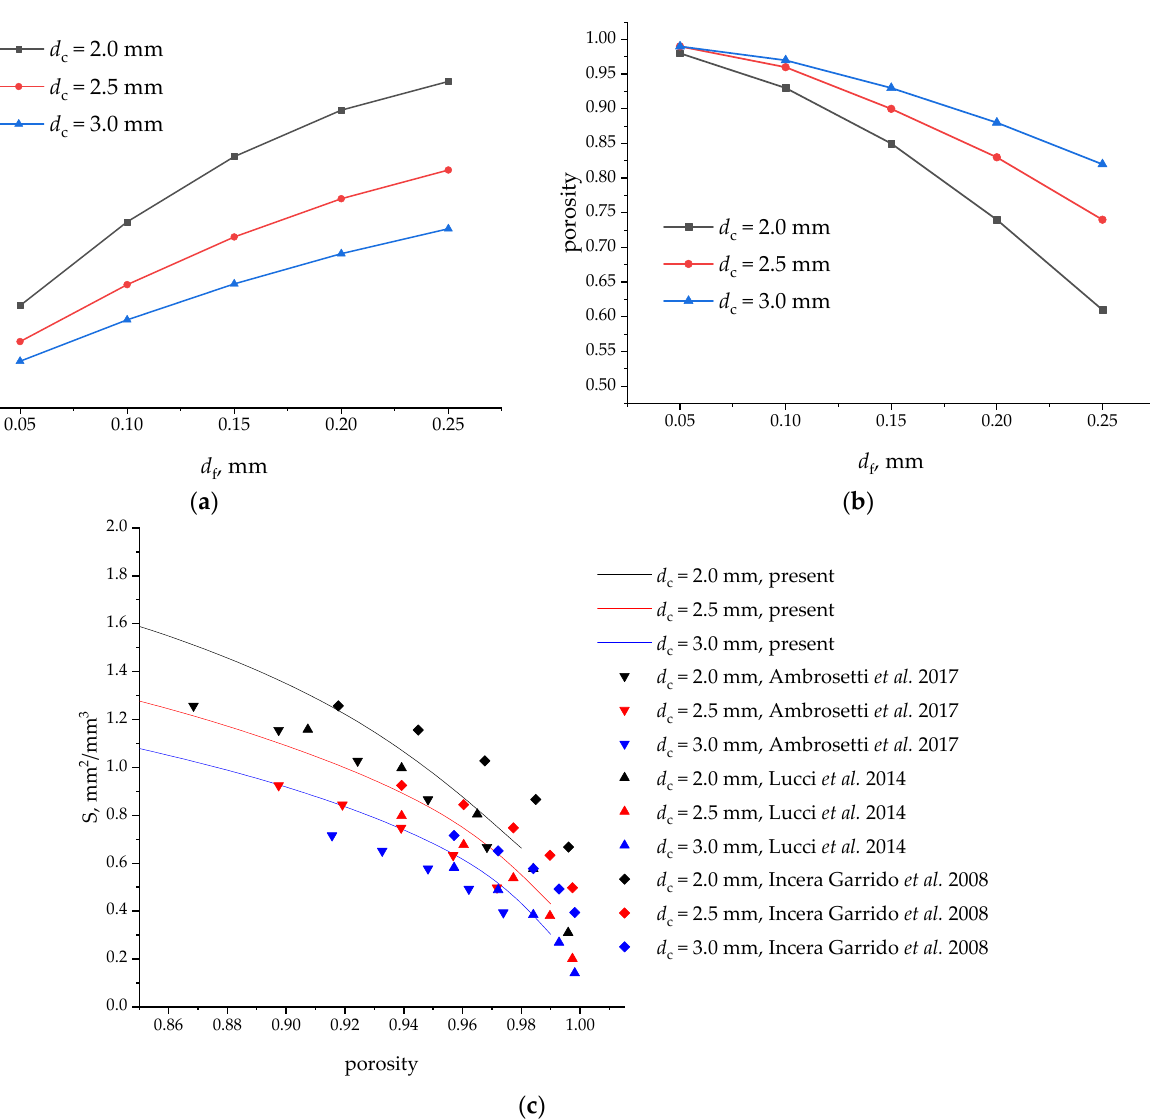
Figure 4. The parameters of the constructed models of open-cell foam structure: ( a ) Surface area referred to the occupied volume (m 2 /m 3 ). ( b ) Porosity. ( c ) Comparison with literature results [44,47,48].